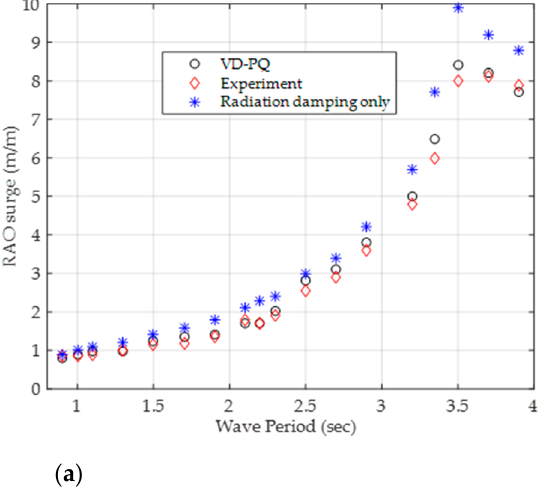
Figure 7. Comparison of heave motion of the examined WEC between experimental data and pre- dictions with use of the velocity-dependent viscous damping model (VD-PQ) and with use of po- tential theory damping for ( a ) wave height equal to 12 mm, ( b ) wave height equal to 25 mm and ( c ) wave height equal to 75 mm.